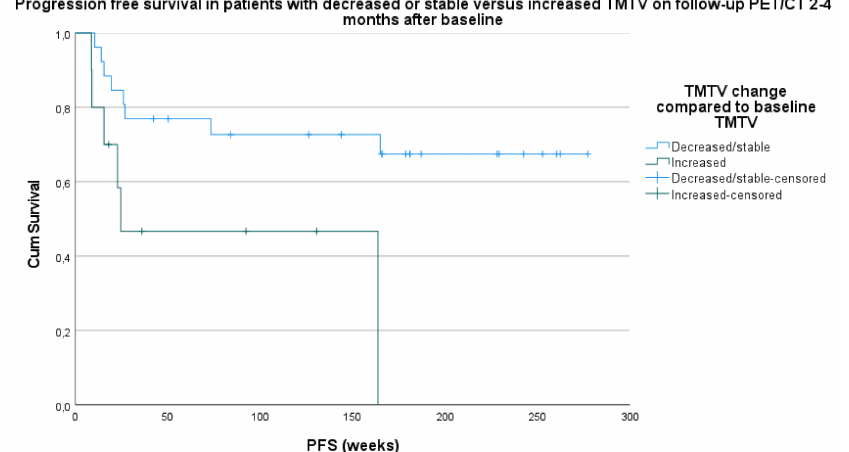
Figure 1. Survival analysis based on progressive free survival (PFS) in patients with stable/decreased TMTV versus increased TMTV on follow-up PET/CT 2–4 months after baseline compared to TMTV on baseline PET/CT.